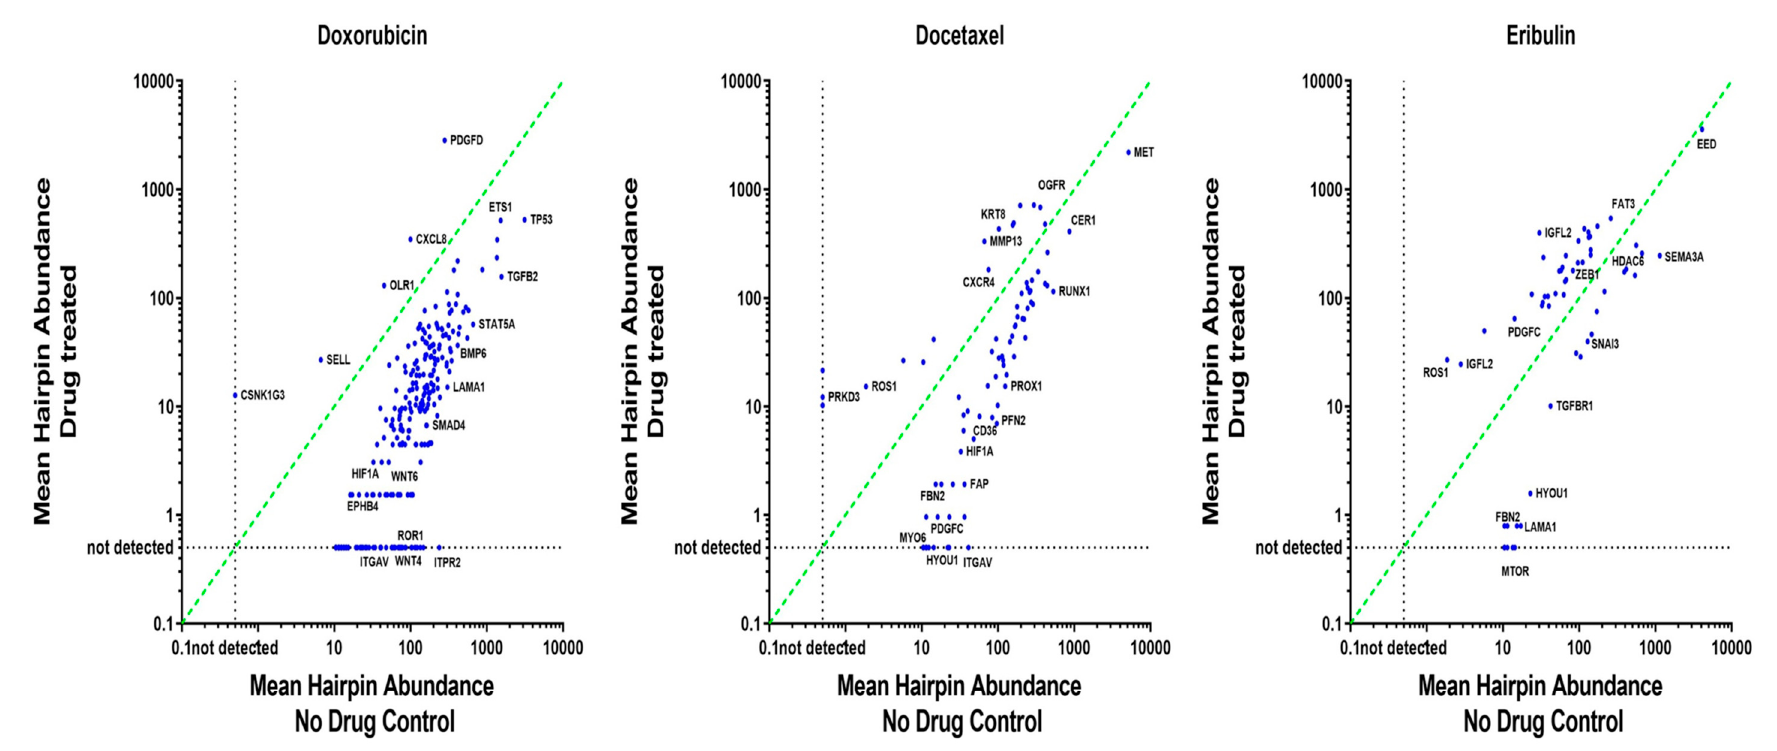
Figure 3. Distribution of hairpin abundance of the normalised reads of shRNAs in drug-treated versus untreated control from Polarity Pool-enriched hairpin library-induced BLT-MDAMB468 cells. Three scatterplots of the mean-normalised reads per shRNA for the shRNA found to be significantly di ff erent between the drug-treated versus untreated cells are shown. The bold diagonal line represents a ratio of 1 for the average amount of shRNA from each of the two conditions. Representative genes corresponding to the shRNA hits depleted during drug treatment are reflected on the right side of the diagonal, and those enriched during drug treatment are reflected on the left side of the diagonal. shRNAs lost during drug treatment are also represented on the horizontal dotted lines.